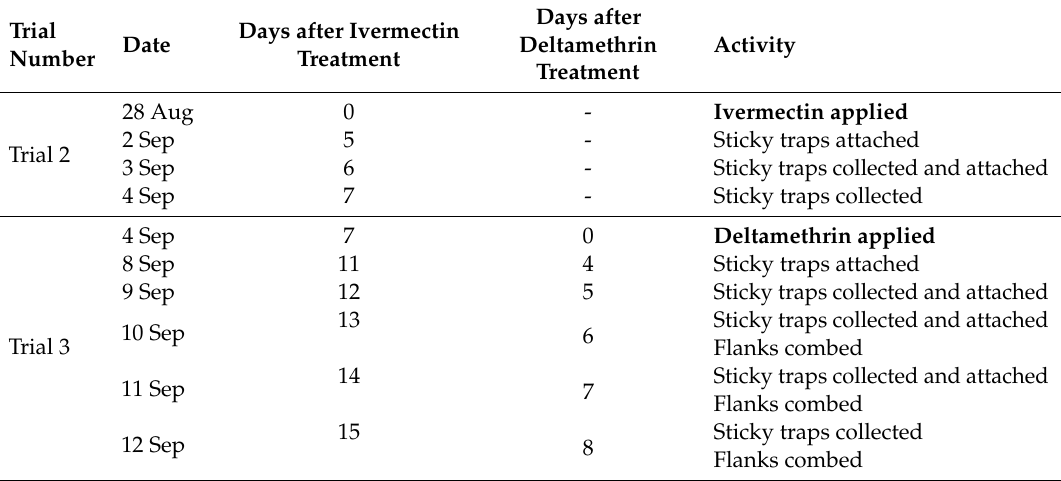
Table 1. Timing of treatments (days after application of ivermectin or deltamethrin) and sampling of heifers for Culicoides using sticky traps and combing in two consecutive trials in a Northern Irish pasture. The ivermectin-treated animals from trial 2 were also sampled in trial 3.